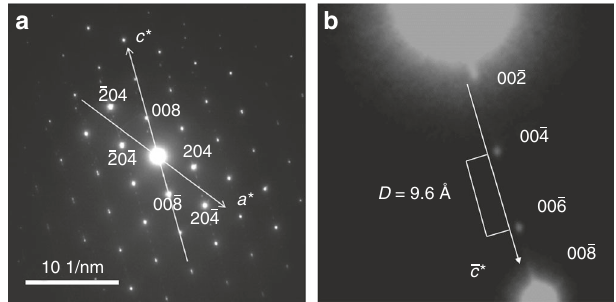
Fig. 2 Identi fi cation of speci fi c Magnéli phases using electron diffraction. a SAED pattern from Ti 6 O 11 . b A magni fi ed image of diffraction spots along c * displaying a repeat distance of 9.6 Å, which is characteristic of the Magnéli phase Ti 6 O 11 . See text and Supplementary Table 1 for